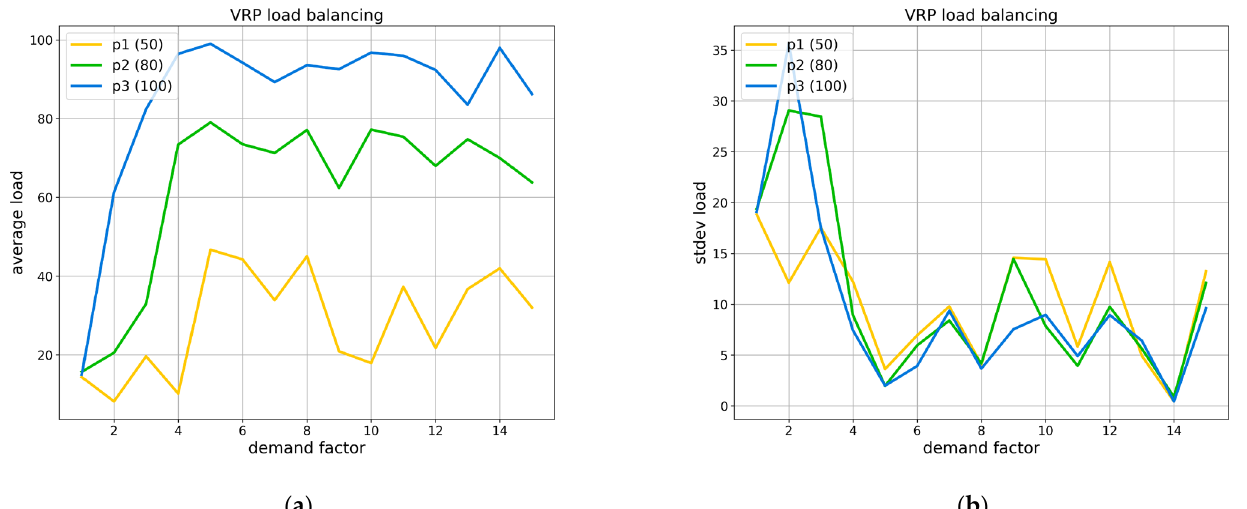
Figure 12. VRP load balancing; ( a ) average load; ( b ) standard